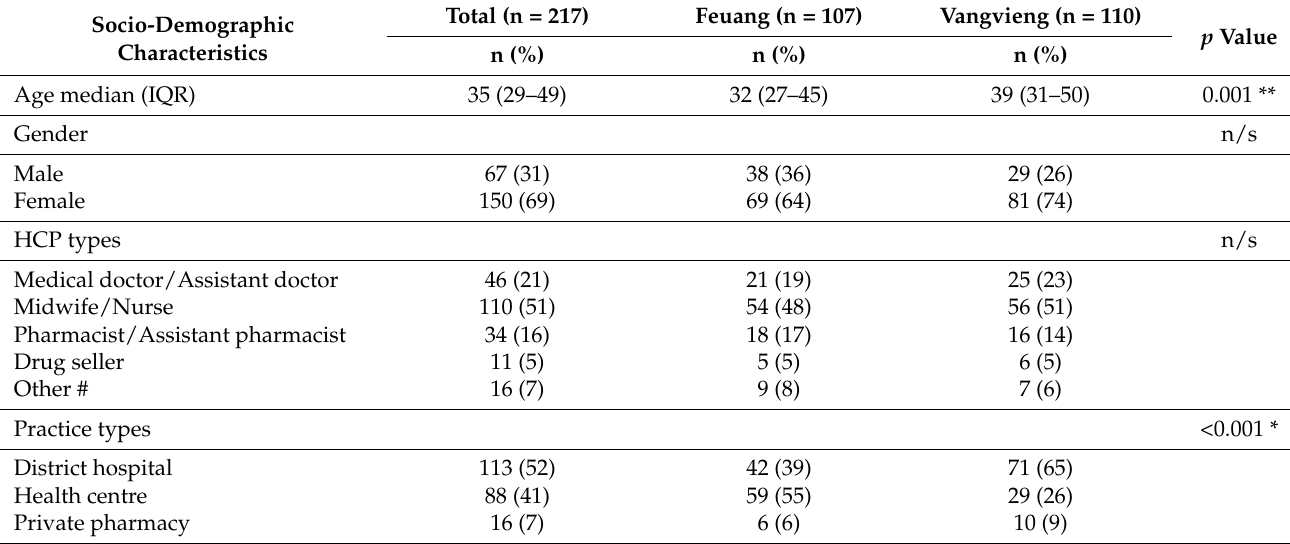
Table 1. Socio-demographic characteristics of participants in the two study